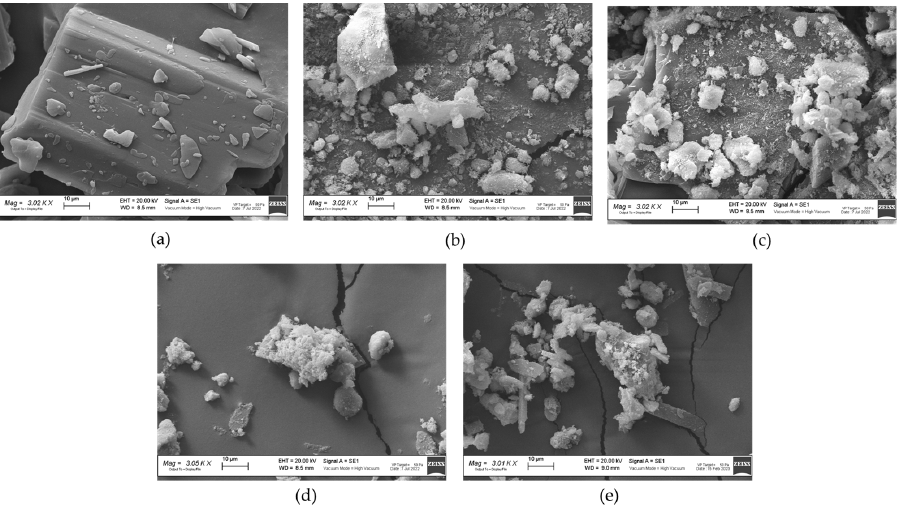
Figure 7. SEM images at 3 kX magnification of C ( a ), CH ( b ), CH_HCl_8M ( c ), CH_H 2 SO 4 _0.5M ( d ), and CH_NaOH_0.5M ( e ).